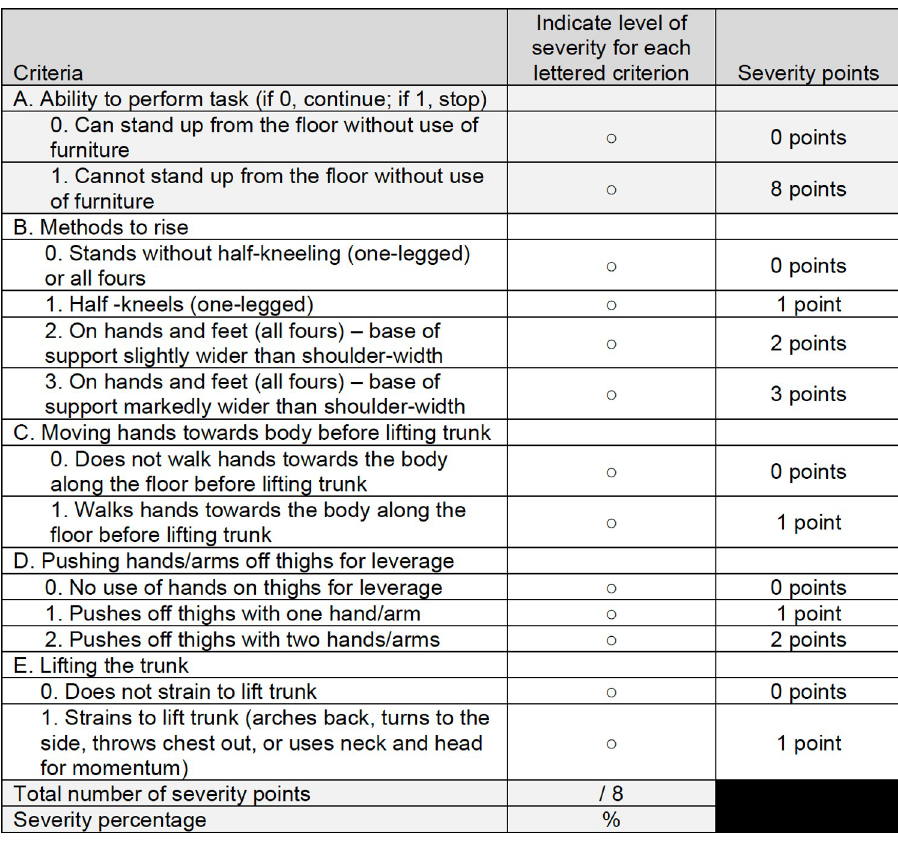
Fig 1. Duchenne Video Assessment scorecard for Stand Up from Sitting on the Floor. Within each compensatory movement criterion, raters select the sub-criterion that indicates the highest level of severity demonstrated in the video. For example, a compensatory criterion when standing up from sitting on the floor is: (D) “Pushing hands/arms off thighs for leverage”. The sub-criteria are: (0) no use of hands on thighs for leverage, (1) pushes off thighs with one hand/arm, and (2) pushes off thighs with two hands/arms. Task severity points are summed for an overall severity score. Not all tasks have the same number of possible points, so a severity percentage is calculated by dividing the severity score by the maximum severity score. Higher severity percentage indicates more compensated movement; the inability to perform a task is assigned the maximum severity score.